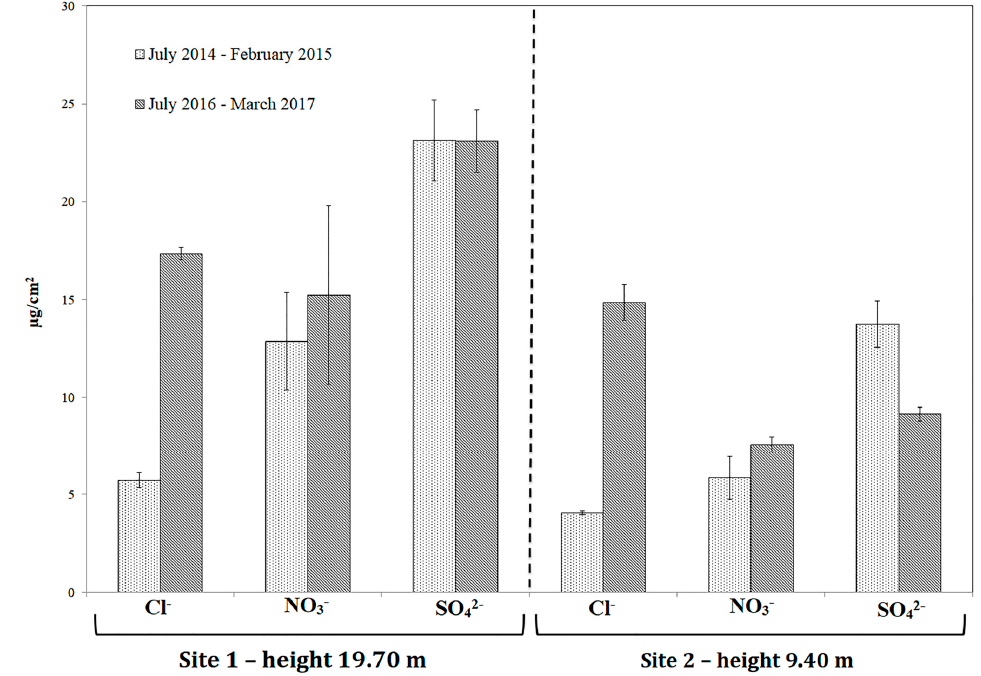
Figure 6. Anions average concentrations determined on the quartz fiber filters exposed in the two sites on the Duomo façade during the two periods.